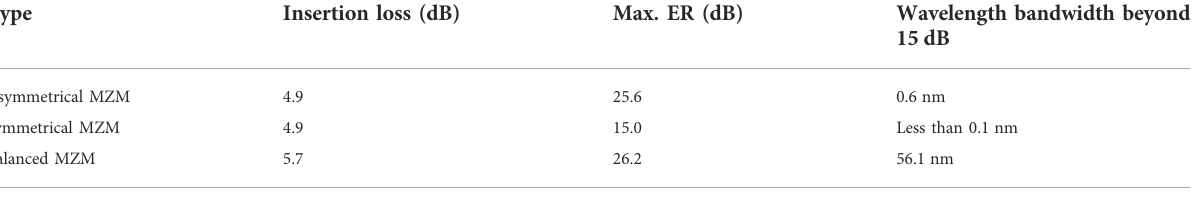
TABLE 2 The performance of the three structures under DC conditions.